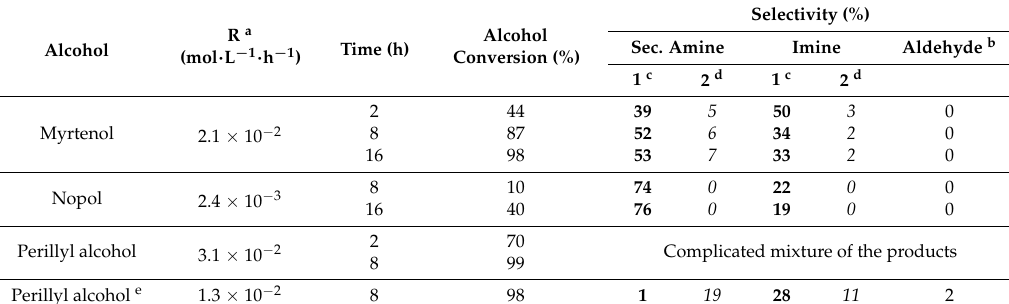
Table 12. Effect of the monoterpene alcohol structure on catalytic behavior of one-pot alcohol amination with aniline. The reaction conditions: T = 180 ◦ C, monoterpene alcohol 1 mmol, aniline 1 mmol, toluene